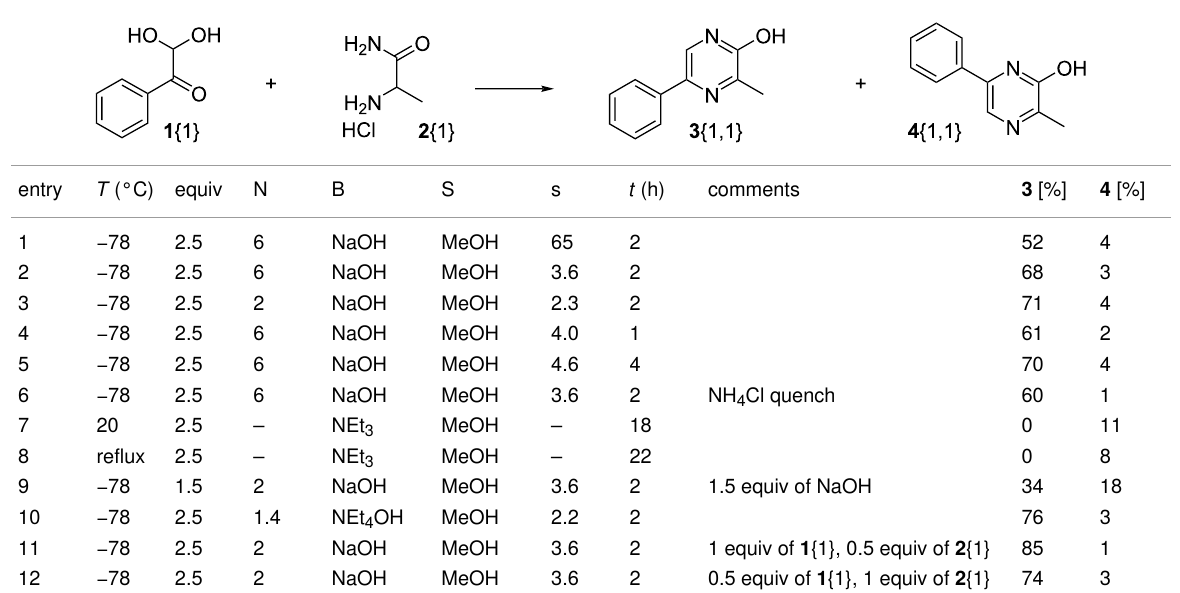
Table 1: Condensation trials between phenylglyoxal ( 1 {1}) and alanine amide ( 2 {1}). a